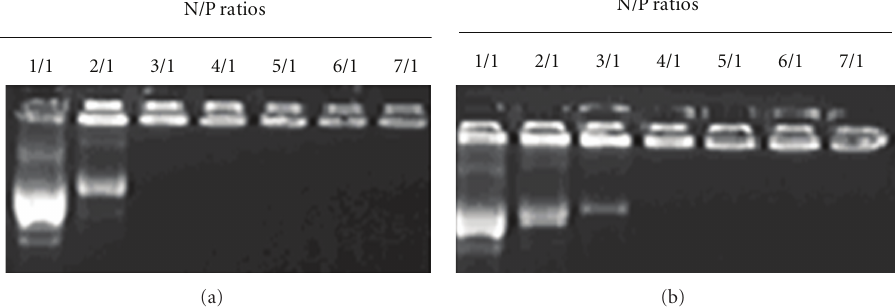
Figure 2: Agarose gel electrophoresis of 0.5 μ g DNA complexed with (a) PEI- β -CyD and (b) CY11-PEI- β -CyD at N/P ratios from 1 to 7.